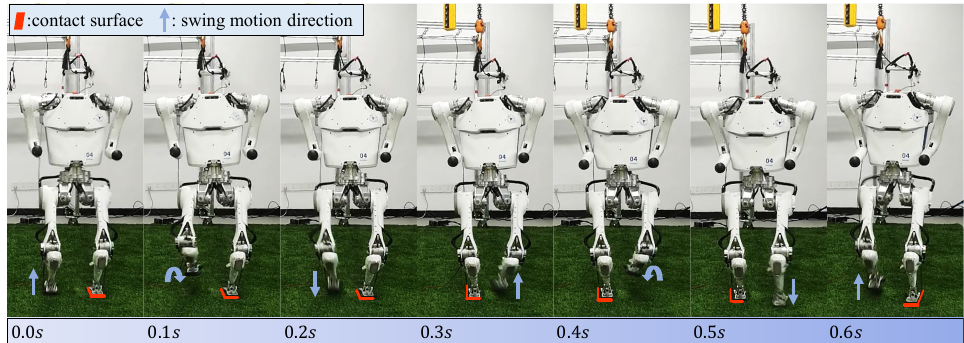
Figure 10. Snapshots of real Wukong-IV robot stepping in place. The trained policy is the same with policy tested in Section 4 (Corresponding video of the snapshots can be found in Supplementary Materials).